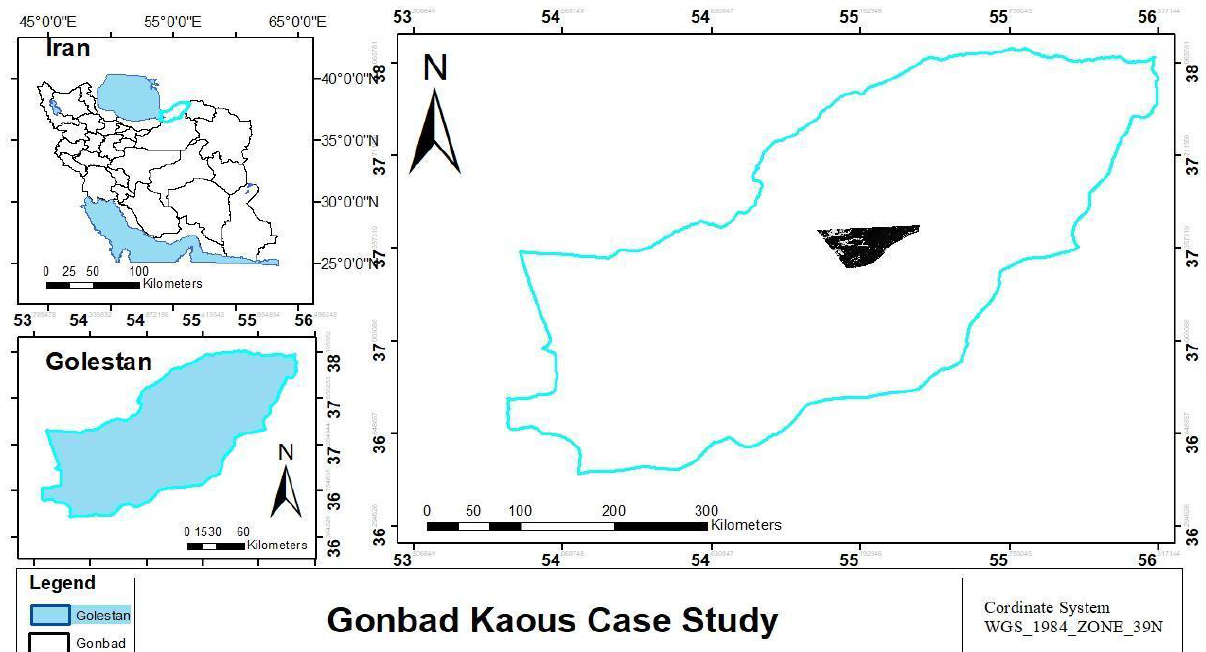
Figure 1. Map of the study area in Golestan, Gonbad-e